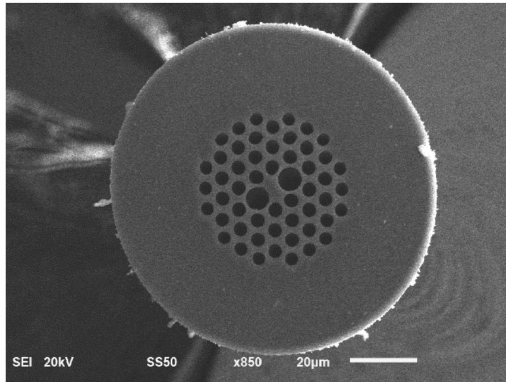
Figure 5. A section of PM–PCF for